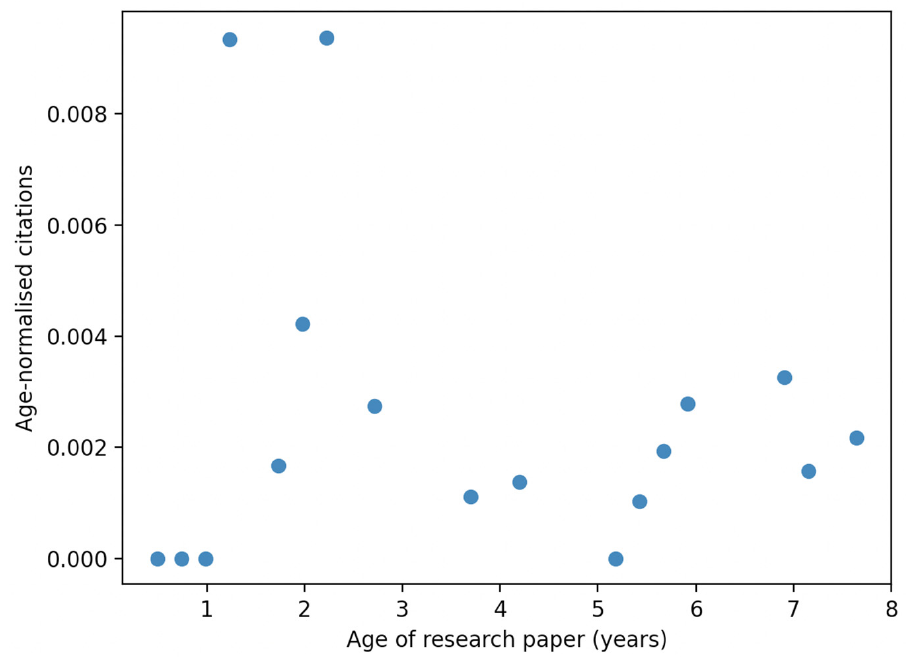
Figure A7. Research papers associated with JOHD/RDJ data papers: average total citation counts over time (3-month ranges).